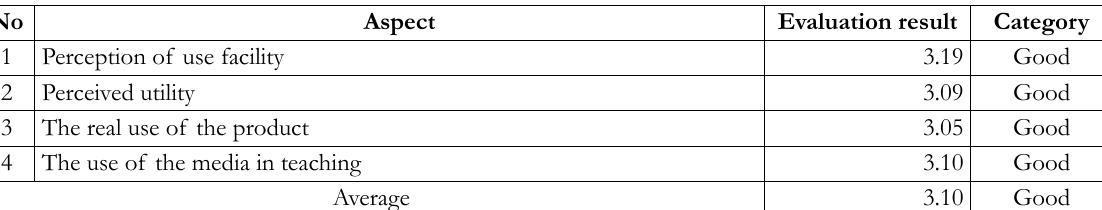
Table 9. Students’s responses in the limited trial